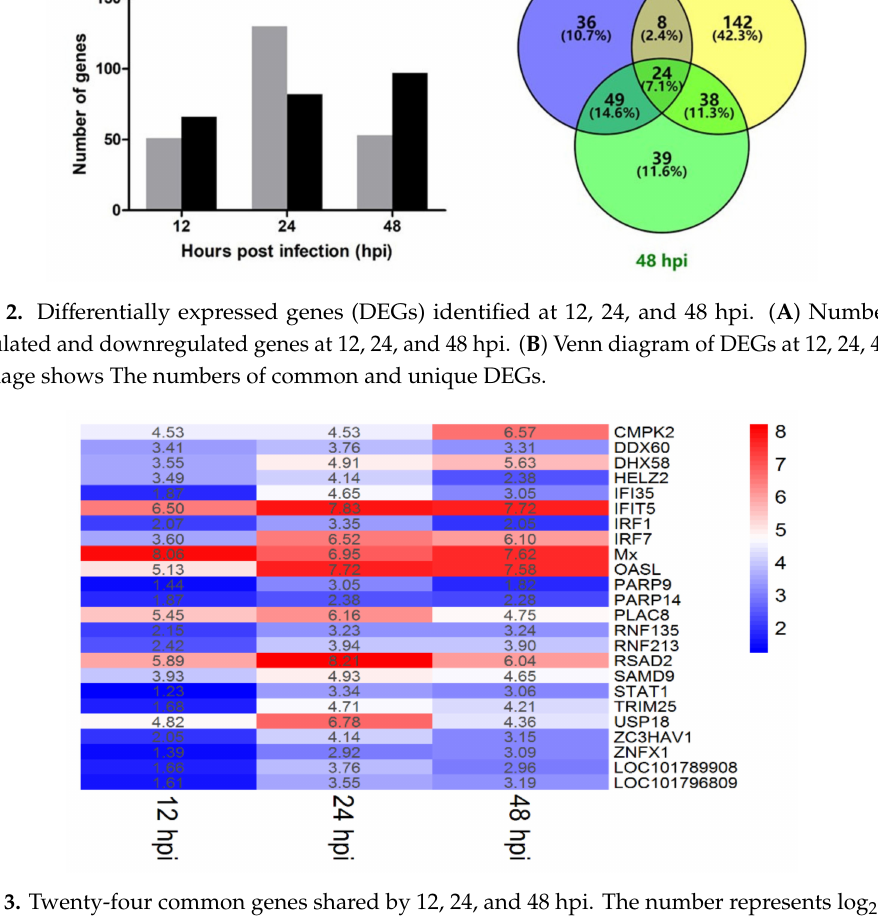
Figure 3. Twenty-four common genes shared by 12, 24, and 48 hpi. The number represents log 2 (fold change) of each gene at di ff erent time